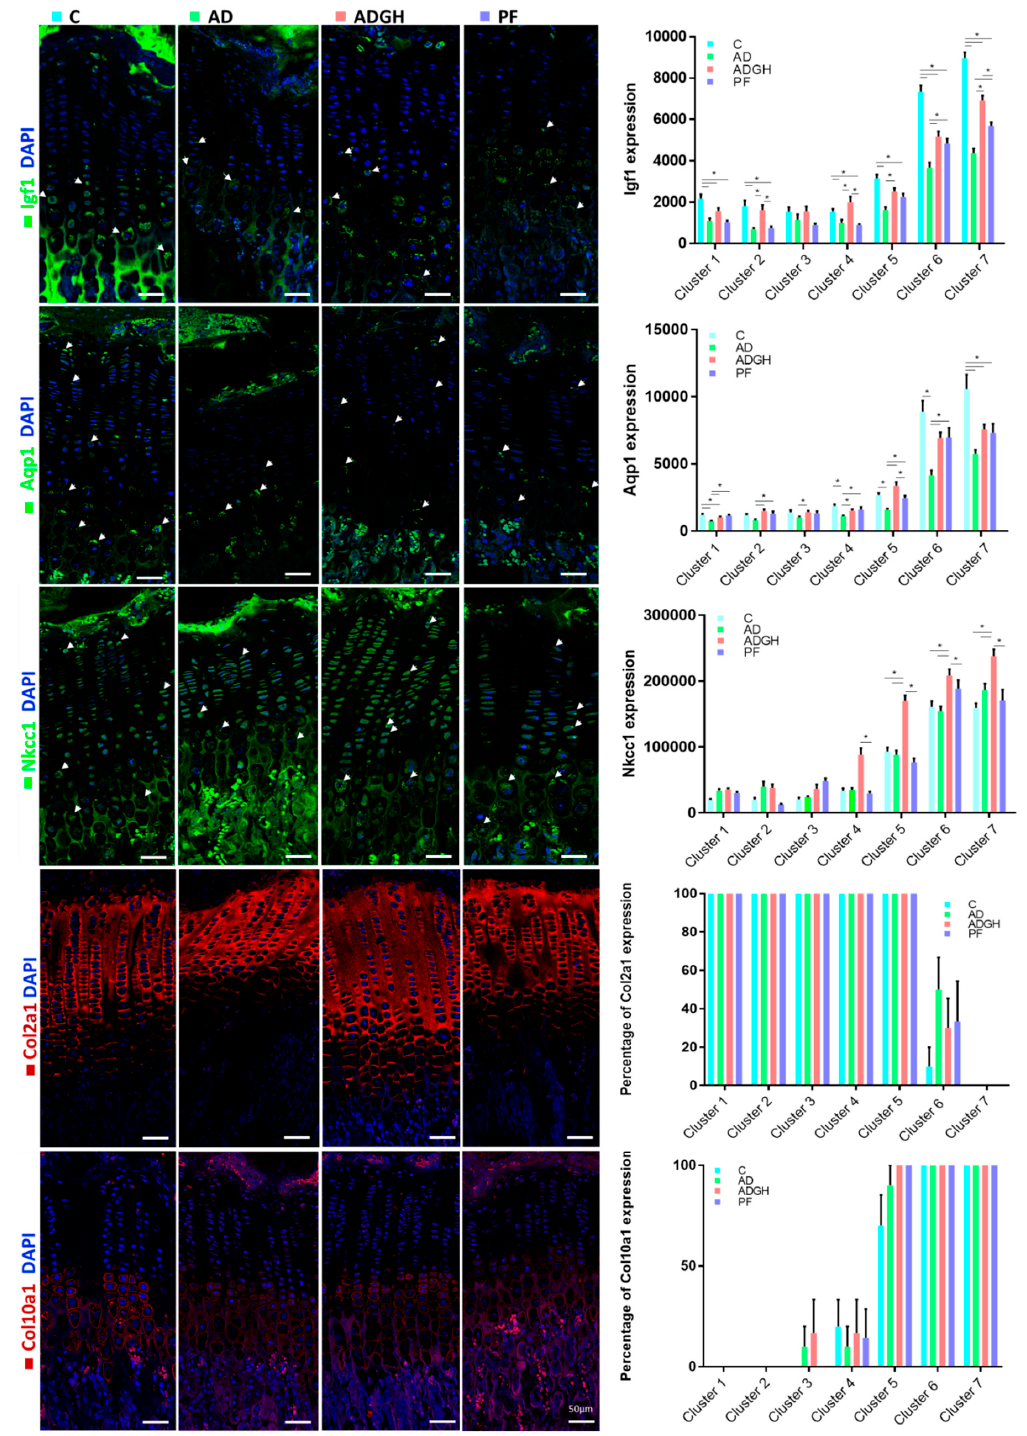
Figure 3. Immunohistochemical analysis of the expression of growth plate markers. Representative images are shown for Igf1 (green), Aqp1 (green), Nkcc1 (green), Col2a1 (red), and Col10a1 (red) and their corresponding quantifications in the seven described clusters. Arrowheads mark some of the labeled cells. Blue nuclei are stained by DAPI. DAPI, 4 ′ ,6-diamidino-2-phenylindole; C, control rats; AD, adenine 0.5% rats; ADGH, adenine 0.5% rats treated with GH; PF, pair-fed rats; Col2a1, collagen 2 alpha chain 1; Col10a1, collagen 10 alpha chain 1; Nkcc1, Na K Cl − cotransporter 1; Aqp1, aquaporin 1; Igf1, insulin growth factor 1. Values are mean ± SEM. * p value <